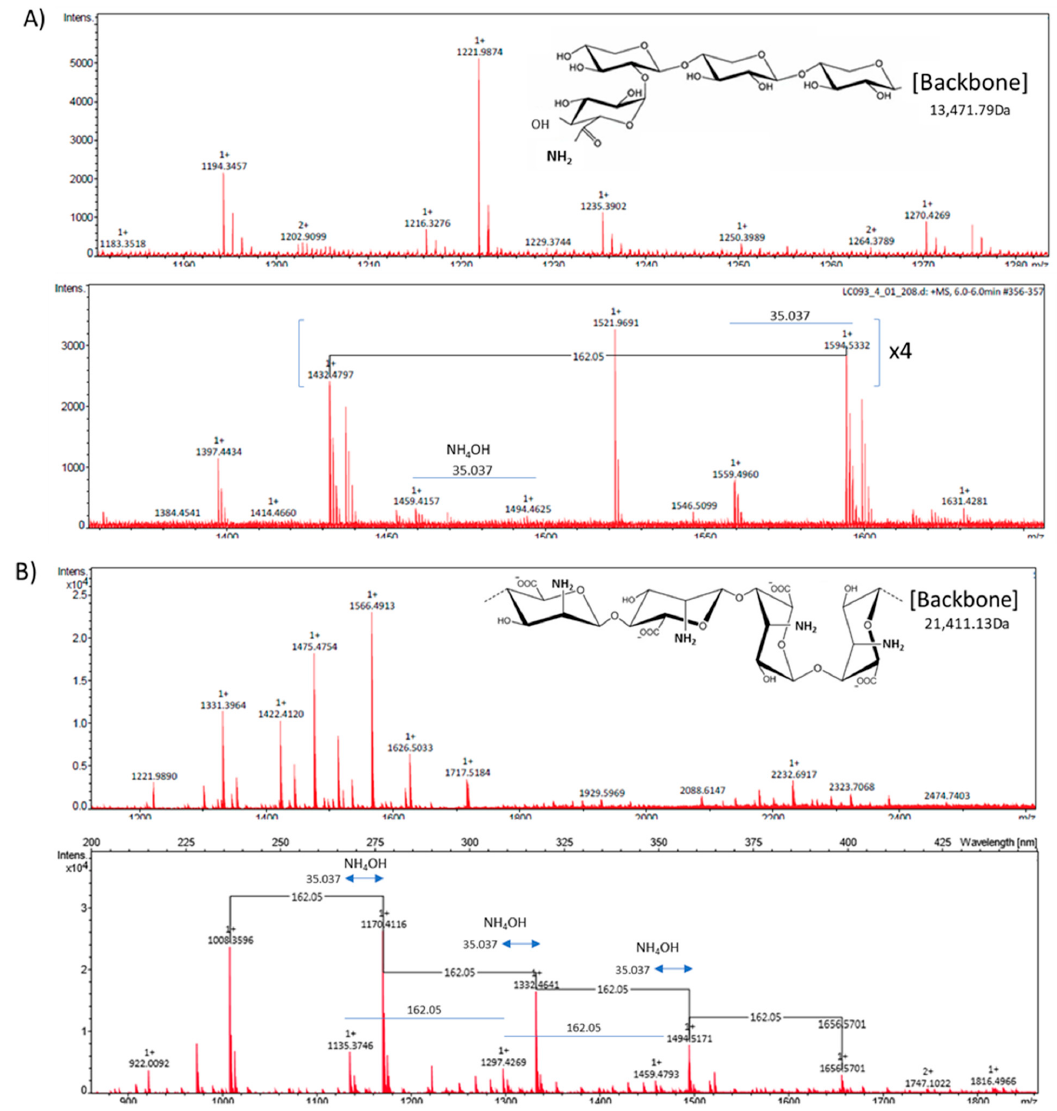
Figure 2. Mass spectrometry ‘ m / z ’ signals from the bioactive fraction obtained from C. quinoa ( A ) and S. hispanica L ( B ) [17,19].